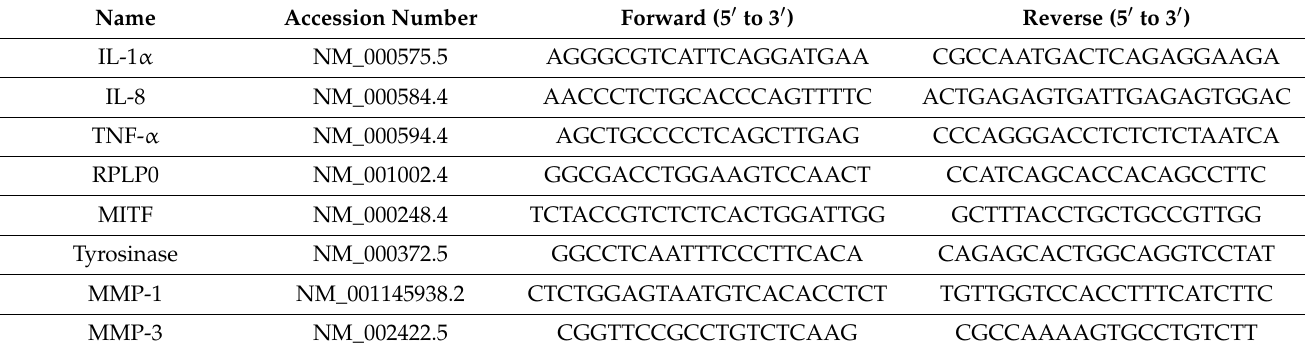
Table 1. List of primers used for quantitative Real-Time Polymerase Chain Reaction